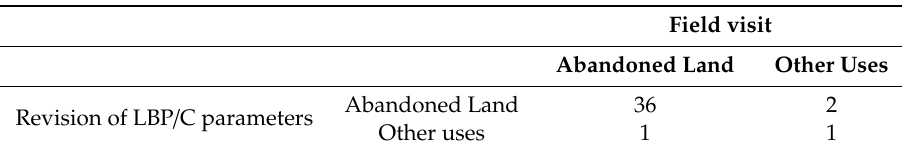
Table 1. Results of the analysis of each inspection